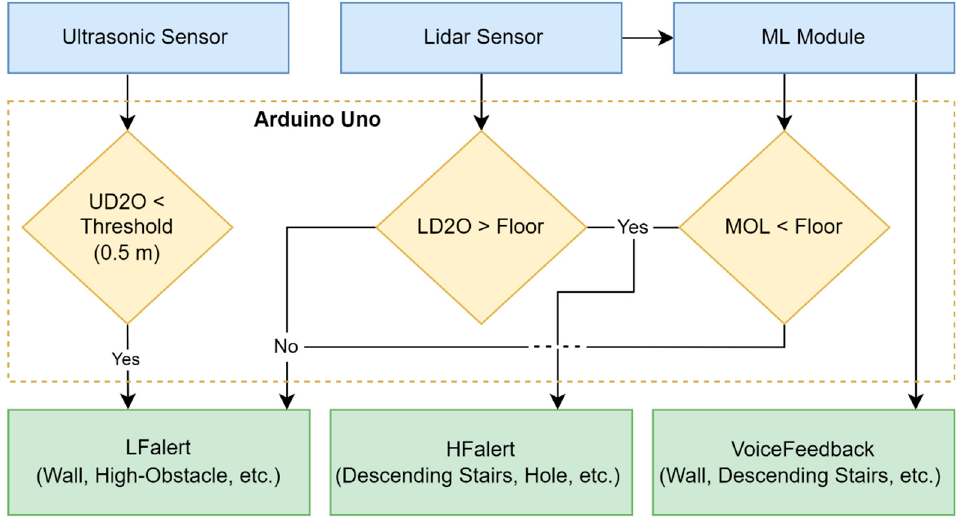
Figure 9. Sensing, warning and verbal Feedback concerning the detected object.